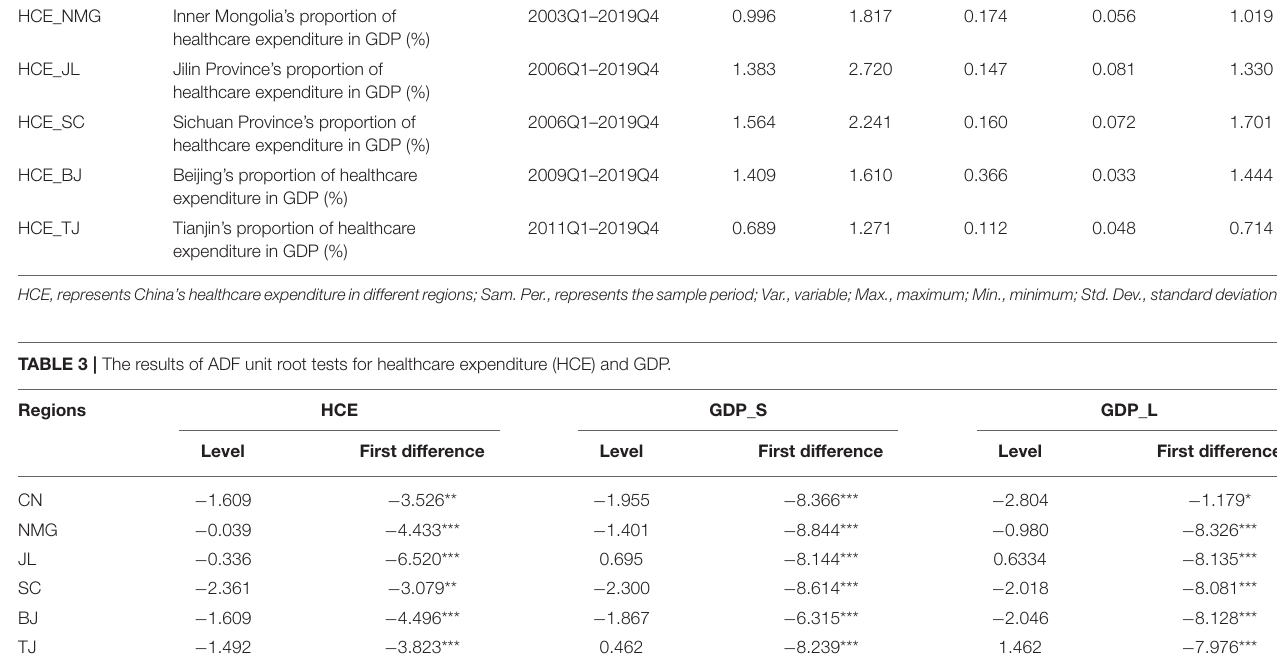
TABLE 2 | Statistical description of China’s healthcare expenditure in different regions. Var. Var. Def. Sam. Per. Mean Max. Min. Std. Dev